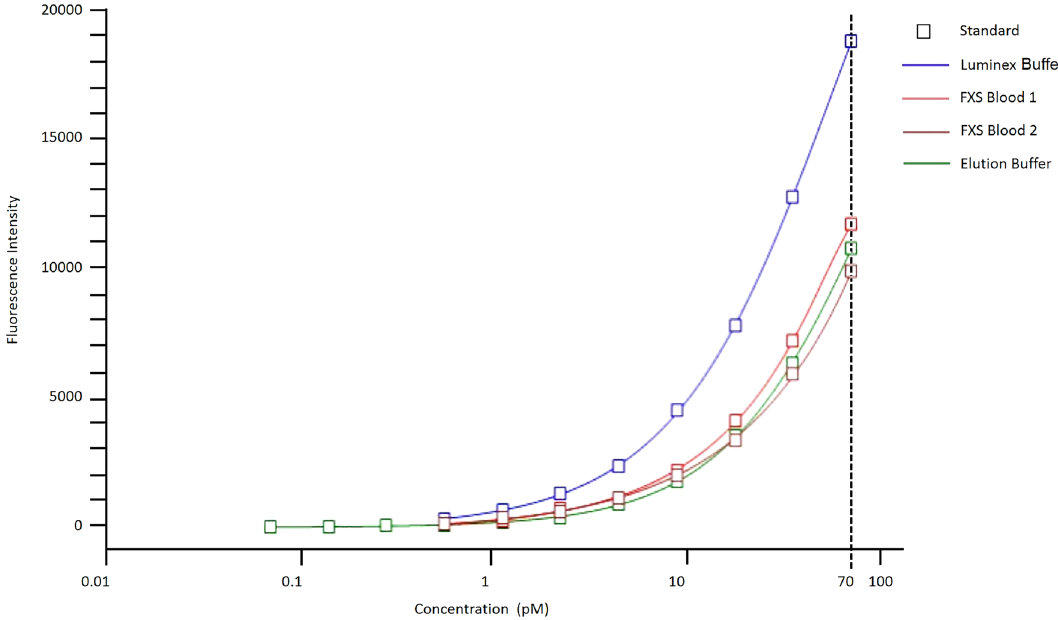
Figure 3. Elution buffer approximates blood matrix effect better than Luminex buffer. Luminex buffer (in blue) was previously used as the standard curve diluent. Due to components within the blood sample demonstrated in the FXS blood curves (both red), fluorescent intensity is globally reduced. This blood matrix effect is mimicked by the elution buffer (in green), allowing the addition of more standard points to lower the detection limit to 0.07 pM. FXS Fragile X Syndrome.